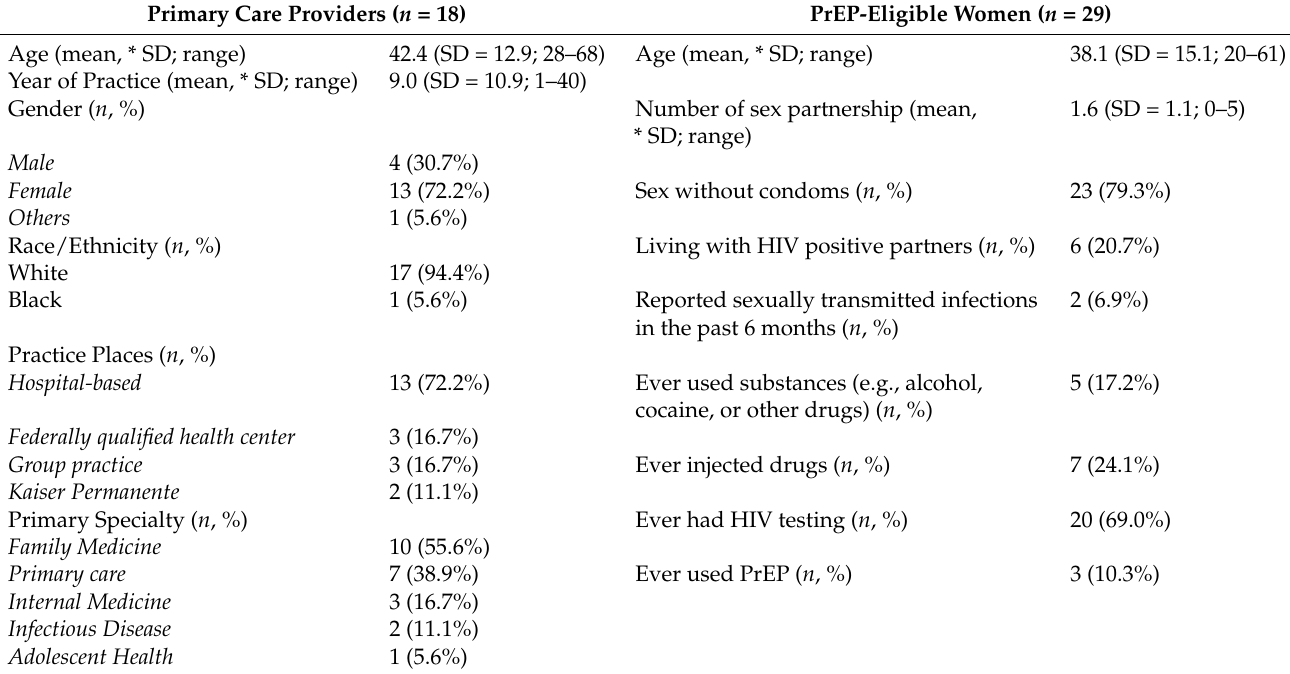
Table 1. Demographics and key characteristics of included participants.